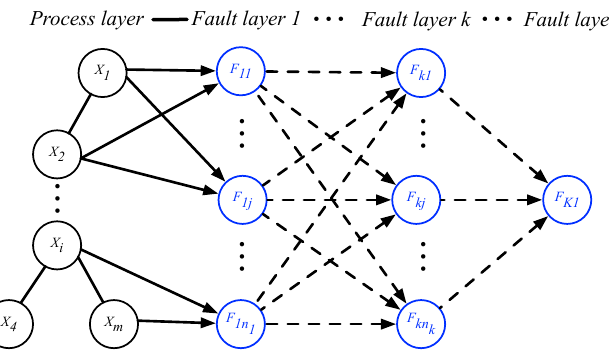
Figure 1. Fault propagation